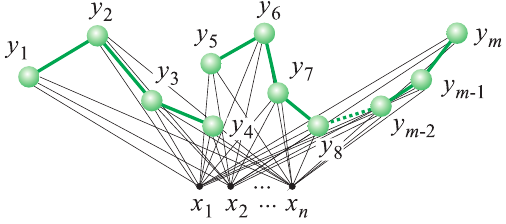
Figure 15. Generalized SOMs (GeSOM) with 1DN (DSOM).